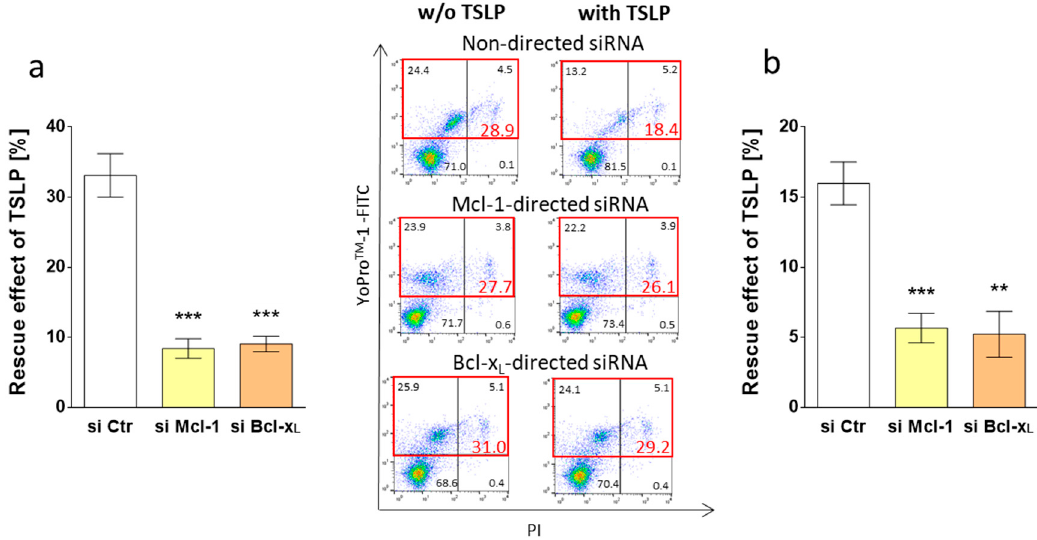
Figure 5. Survival prolongation by TSLP depends on Mcl-1 and Bcl-x L . Impact of Mcl-1 and Bcl-x L knockdown on TSLP-promoted MC recovery (at 7.5 ng / mL), as evaluated by apoptosis reduction in TSLP-treated versus untreated MCs after 8 h. ( a ) Reduction of YoPro TM -1-positivity (corresponding to the percentage of early and late apoptotic / necrotic cells combined) as mean ± SEM of nine independent experiments (left) and representative flow cytometry dot plots (right) (specified in red is the percentage of early and late apoptotic / necrotic cells combined); w / o—without; ( b ) reduction of caspase-3 activity as mean ± SEM of nine independent experiments. The data were analyzed by paired t -test, ** p < 0.01, *** p < 0.001.